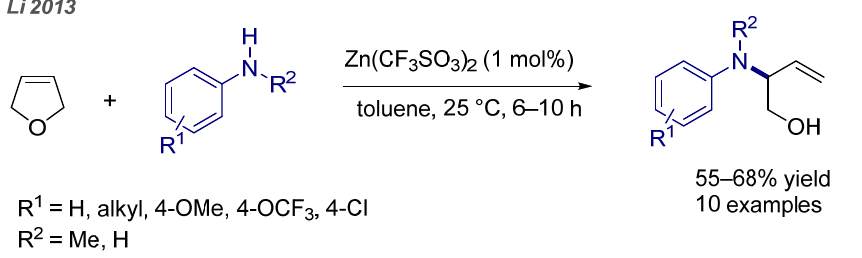
Figure 30. Zn(CF 3 SO 3 ) 2 -catalyzed hydroamination-ring cleavage of 2,5-dihydrofuran with aro- matic amines.